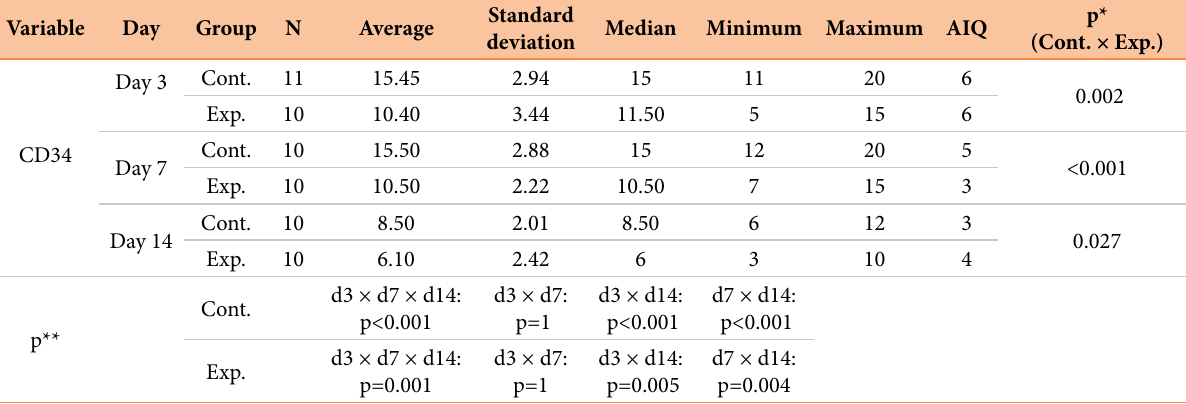
Table 3 - Mean number of vessels in 10 fields (marked by anti-CD34).